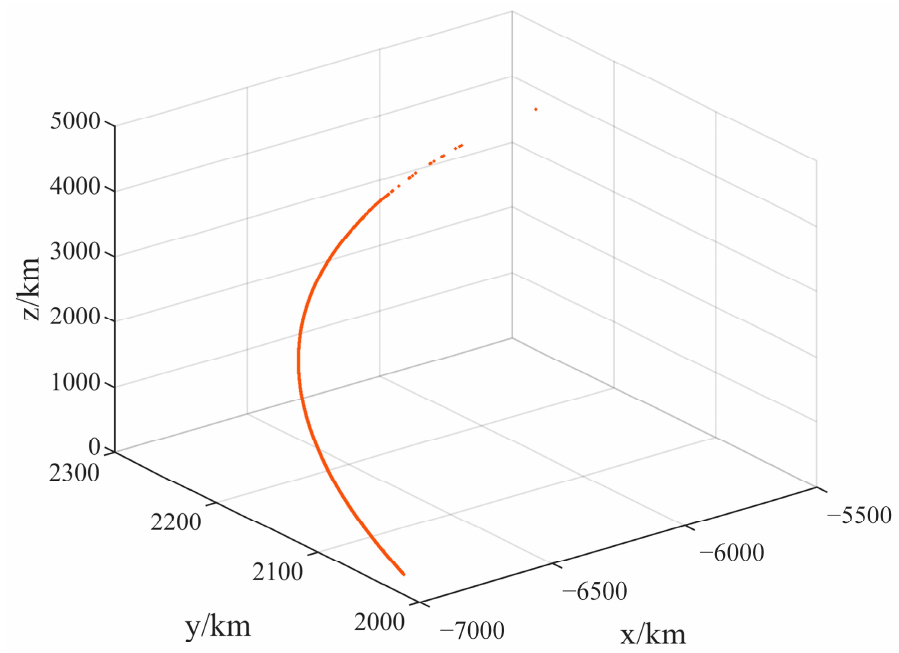
Figure 14. Experimental results of measurable arc.